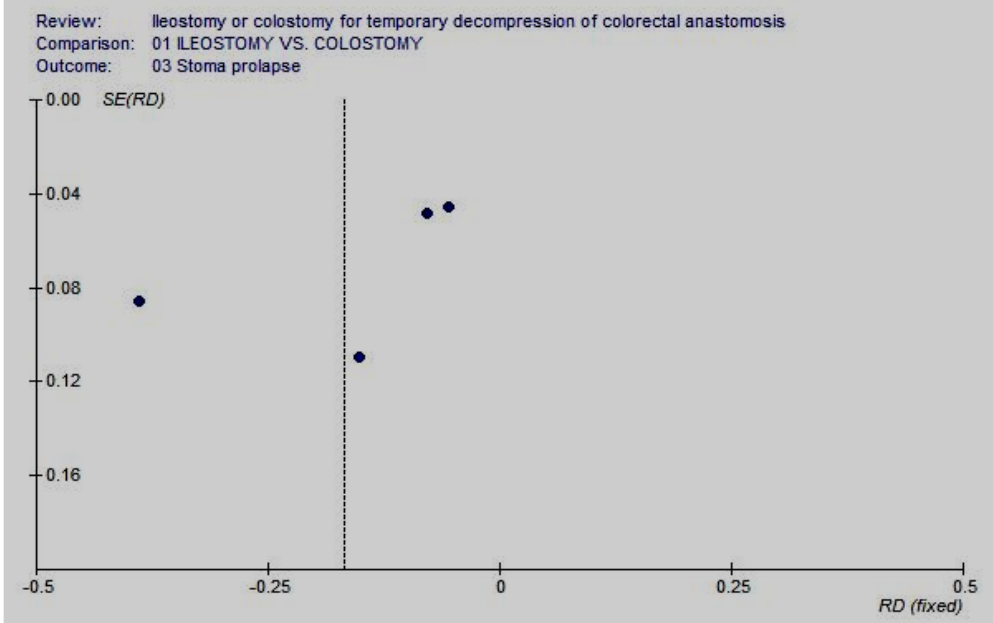
FIGURE 4 – Funnel plot for the outcome of stoma prolapse